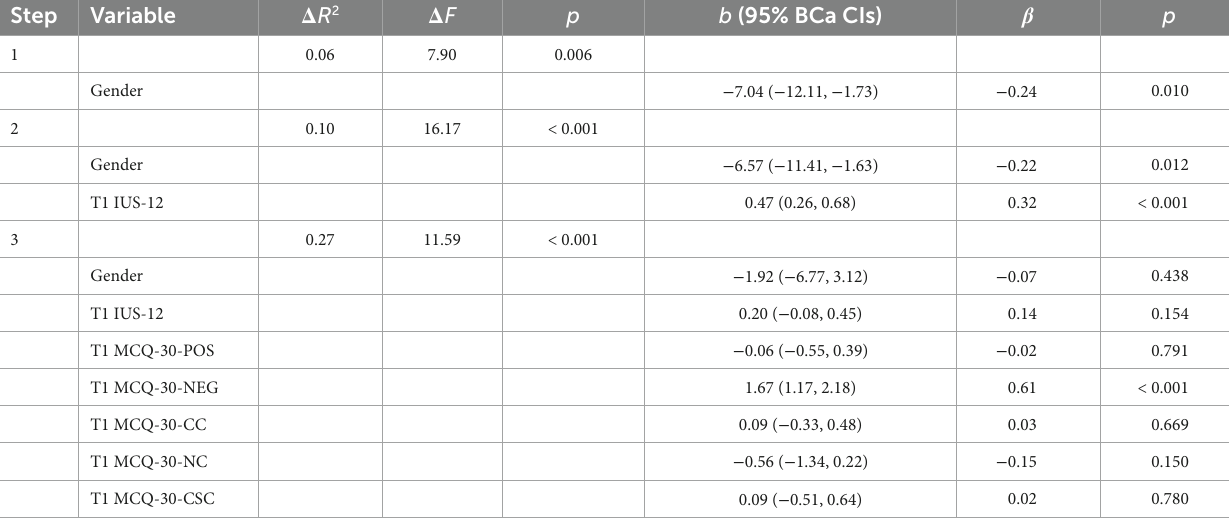
TABLE 3 Hierarchical linear regression, predicting Time 2 state test anxiety